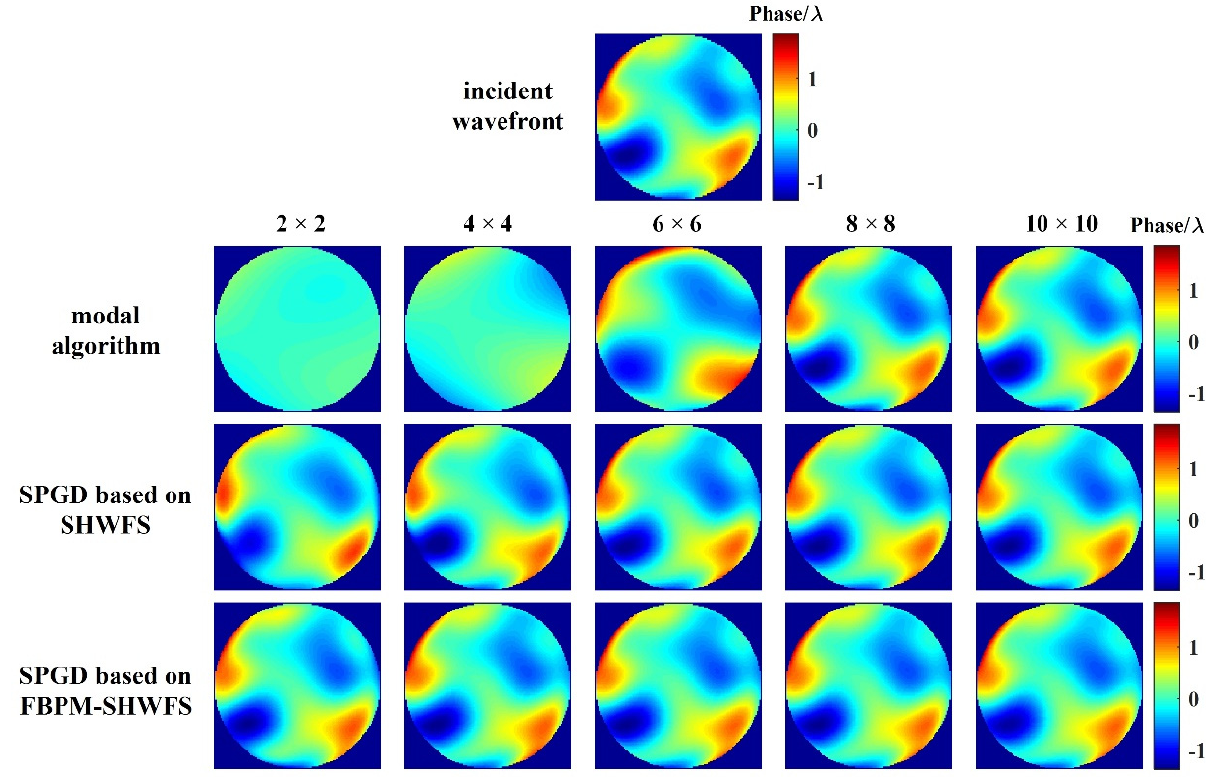
Figure 9. Results of wavefront reconstruction for three methods with different subaperture numbers.